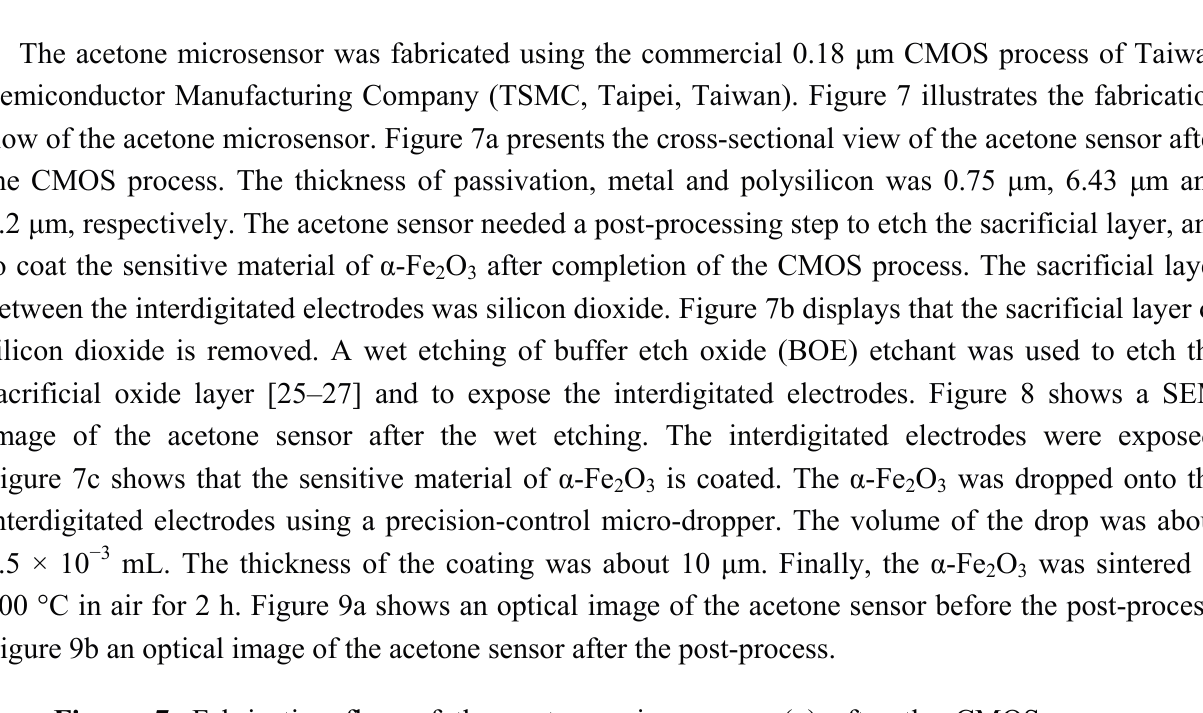
Figure 7. Fabrication flow of the acetone microsensor, ( a ) after the CMOS process; ( b ) removing the sacrificial oxide layer; ( c ) coating the sensitive α -Fe